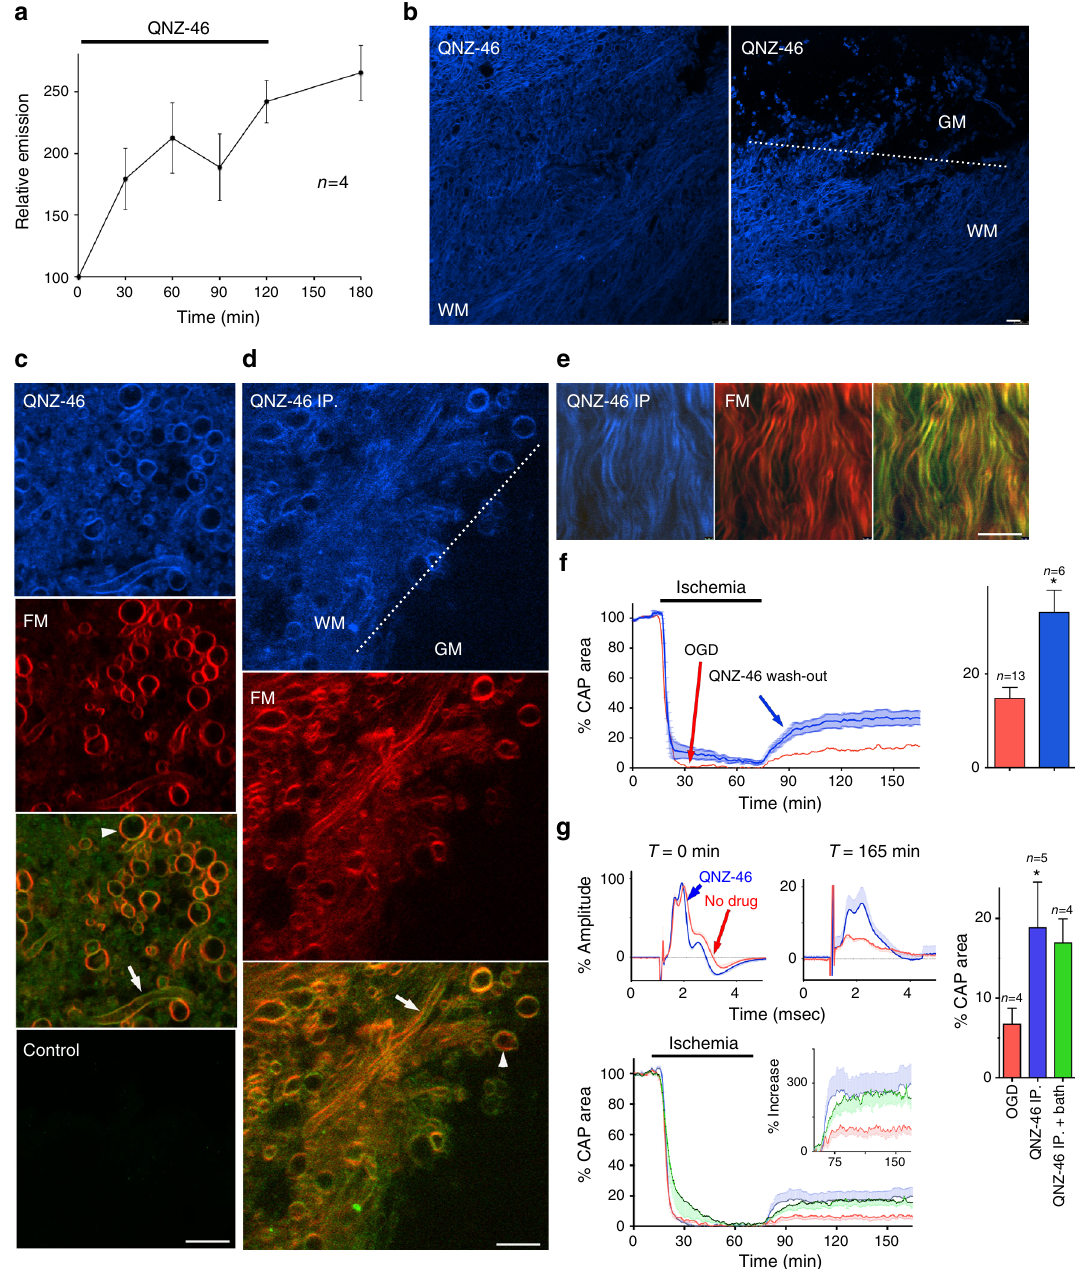
Fig. 6 QNZ-46 is absorbed by myelin. a QNZ-46 emission shows accumulation and retention in adult rat RON. b Confocal imaging of vital QNZ-46 fl uorescence (120 min treatment) in adult corpus callosum (left) and the white matter – gray matter border (right). c Vital QNZ-46/FM co-staining of myelinated axon pro fi les. d , e Vital QNZ-46/FM co-staining in brain slice ( d ) and RON ( e ) following systemic QNZ-46 injection 4 h pre-sacri fi ce. f 60 min QNZ-46 pre-treatment + 60 min wash-out is functionally protective of adult rat RON (ANOVA with Holm − Š ídák post test; P = 0.037). g Systemic QNZ- 46 pre-treatment is functionally protective of mouse RON perfused with aCSF (blue, P = 0.047), and is not signi fi cantly different when QNZ-46 is included in the bath (green). Note, proportional recovery was similar to that found in Fig. 3c (insert). Merged images recolored for clarity. Scale bars = 5 μ